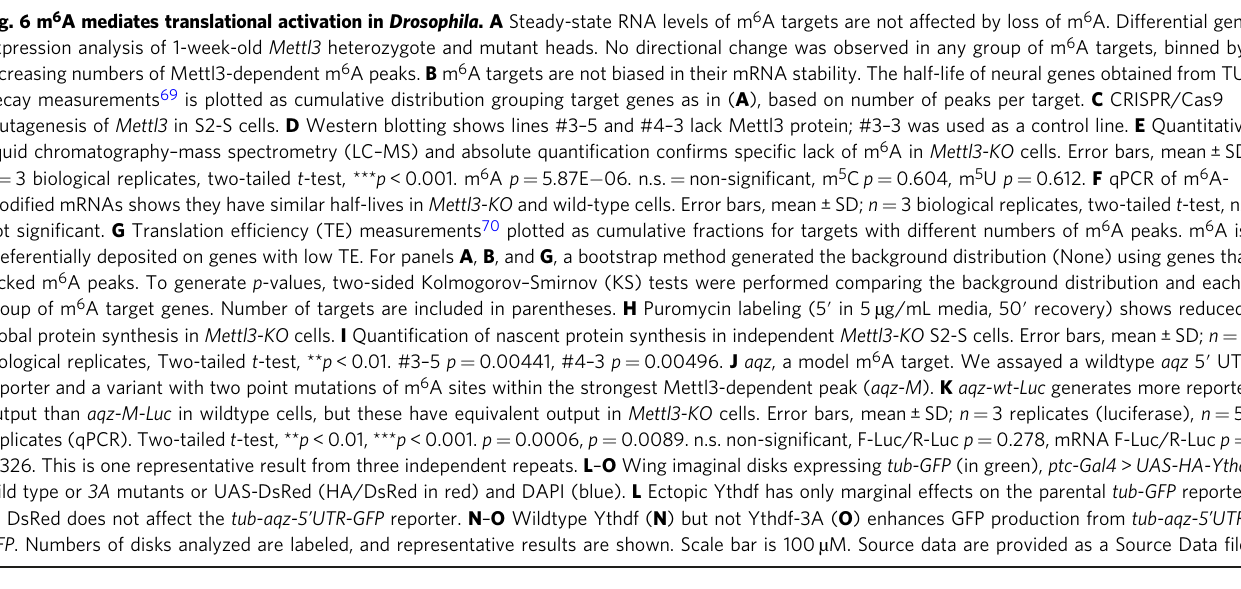
Fig. 6 m 6 A mediates translational activation in Drosophila . A Steady-state RNA levels of m 6 A targets are not affected by loss of m 6 A. Differential gene expression analysis of 1-week-old Mettl3 heterozygote and mutant heads. No directional change was observed in any group of m 6 A targets, binned by increasing numbers of Mettl3-dependent m 6 A peaks. B m 6 A targets are not biased in their mRNA stability. The half-life of neural genes obtained from TU- decay measurements 69 is plotted as cumulative distribution grouping target genes as in ( A ), based on number of peaks per target. C CRISPR/Cas9 mutagenesis of Mettl3 in S2-S cells. D Western blotting shows lines #3 – 5 and #4 – 3 lack Mettl3 protein; #3 – 3 was used as a control line. E Quantitative liquid chromatography – mass spectrometry (LC – MS) and absolute quanti fi cation con fi rms speci fi c lack of m 6 A in Mettl3-KO cells. Error bars, mean ± SD; n = 3 biological replicates, two-tailed t -test, *** p < 0.001. m 6 A p = 5.87E − 06. n.s. = non-signi fi cant, m 5 C p = 0.604, m 5 U p = 0.612. F qPCR of m 6